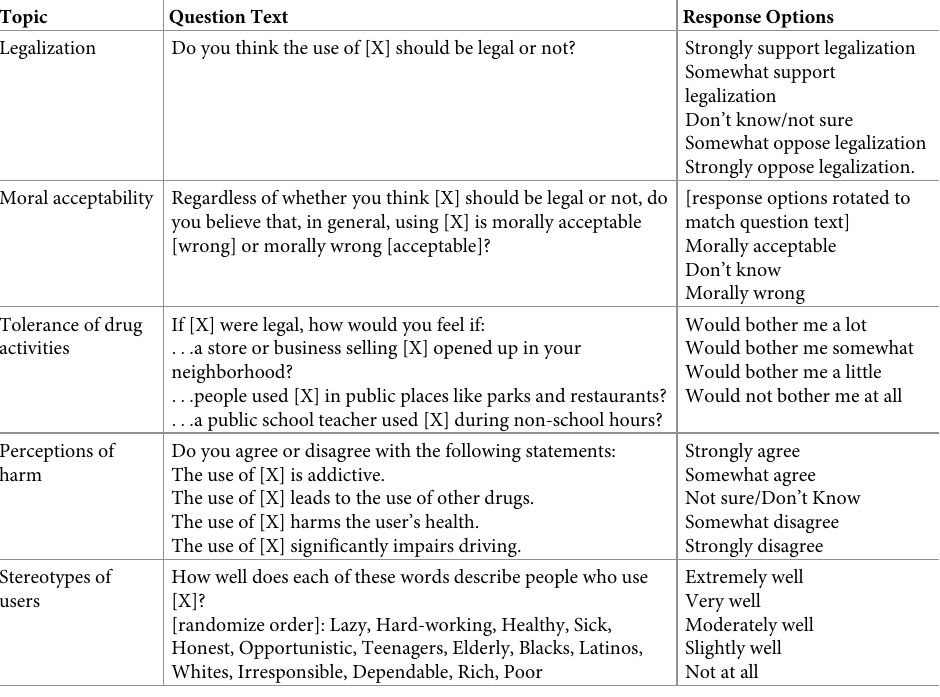
Table 2. Question text and response